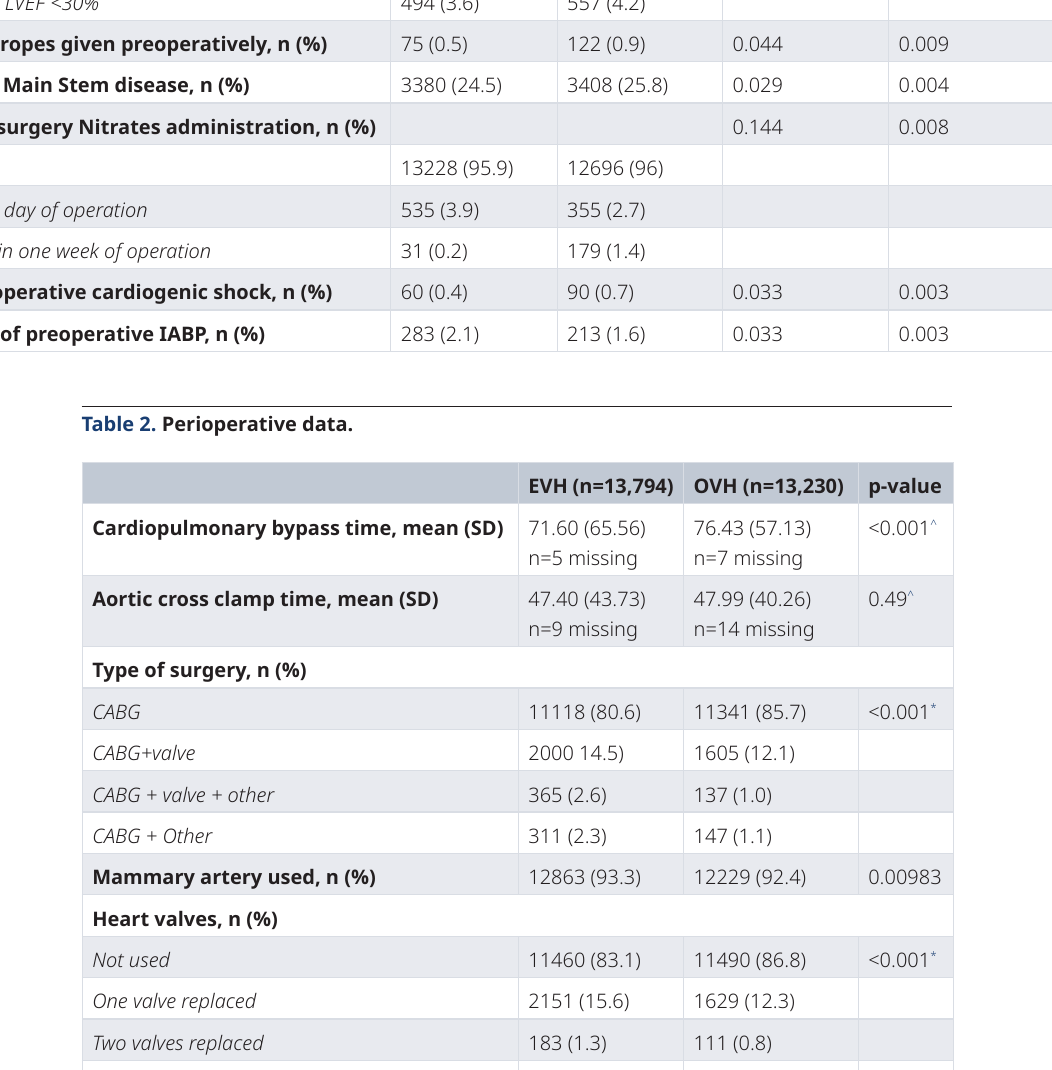
for complete case data and 0.851 (0.789, 0.919) for weighted complete case data. Kaplan-Meier plots for the raw data, com- plete case data and weight complete case data are depicted in